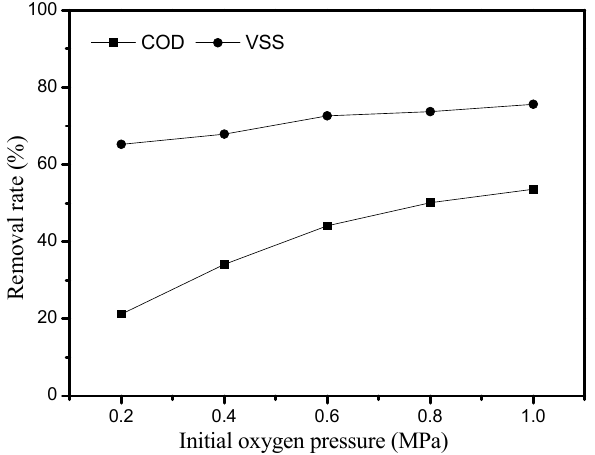
Figure 5. Effect of oxygen dosage on the COD and VSS removal rates (Time: 60 min; Temp.: 220 °C; Catalyst: 0.5 g).